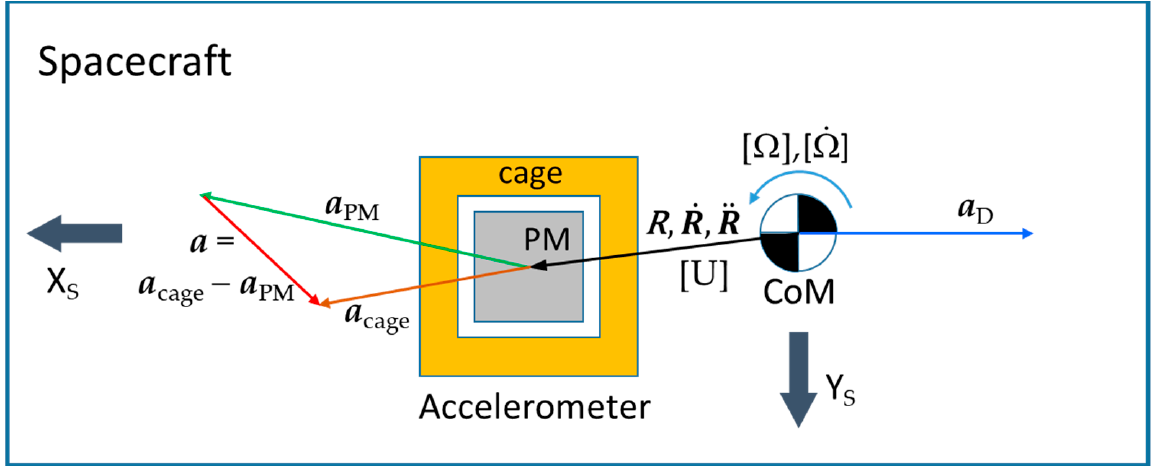
Figure 6. Contributors to the acceleration a nominally measured by the accelerometer.